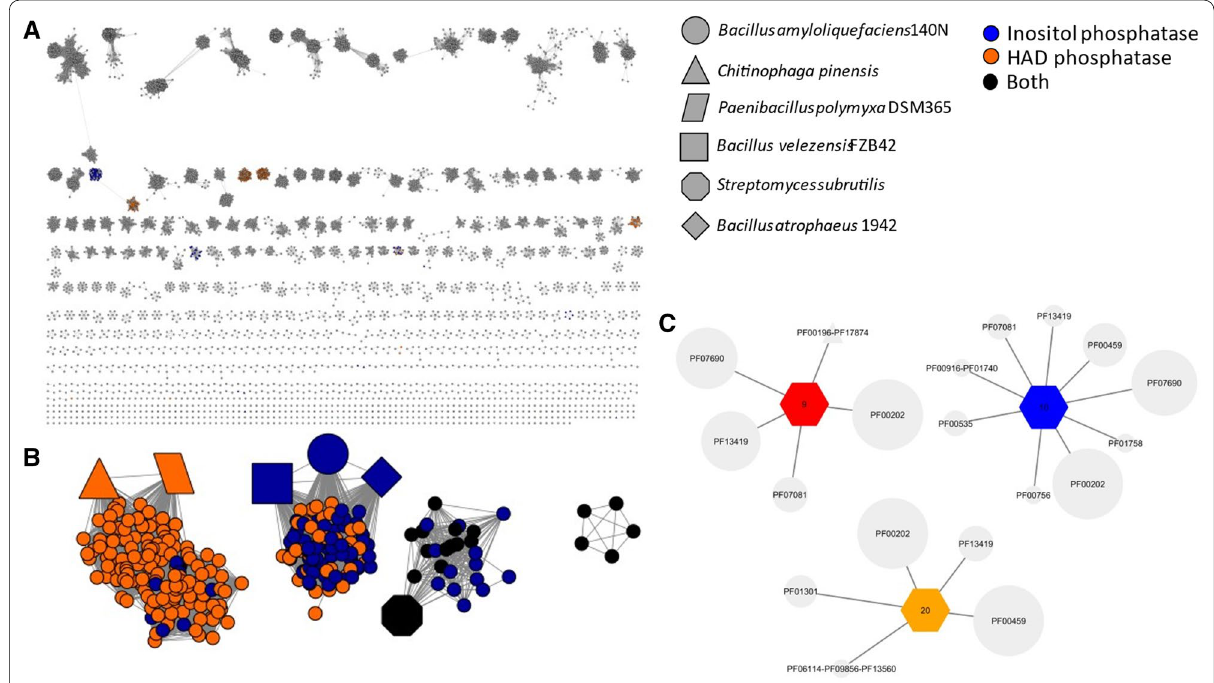
Fig. 4 A Dehydrogenase SSN with alignment score thresholds corresponding to 40% identity. B Dehydrogenase SSN with only the 3GC nodes. C GNN for clusters with known azasugar representation: 9,10 and 20. Polygons identify species as defined for Fig.